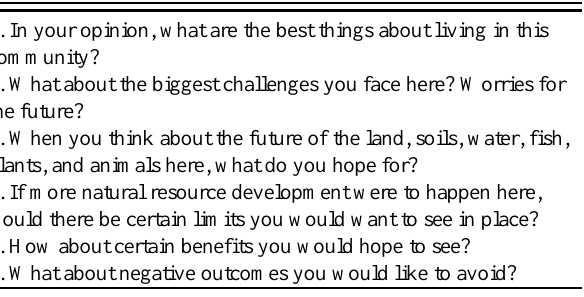
Table 2. Questions on desirable